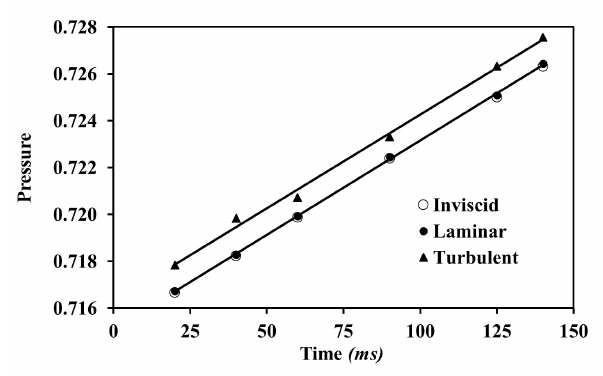
Fig. 5. Time evolution of the normalized average pressure at the backward-facing step surface for different